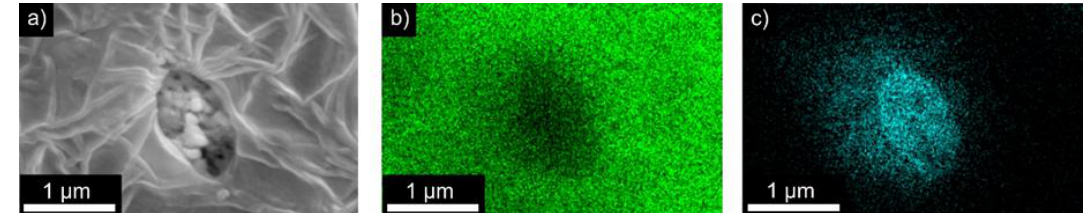
Figure 3. SEM/EDX analysis of a P(VDF-TrFE) composite material with a (Cd:Zn)S particle concentration of 10 vol %: ( a ) SEM micrograph; ( b , c ) corresponding EDX maps for fluorine and sulfur, respectively.